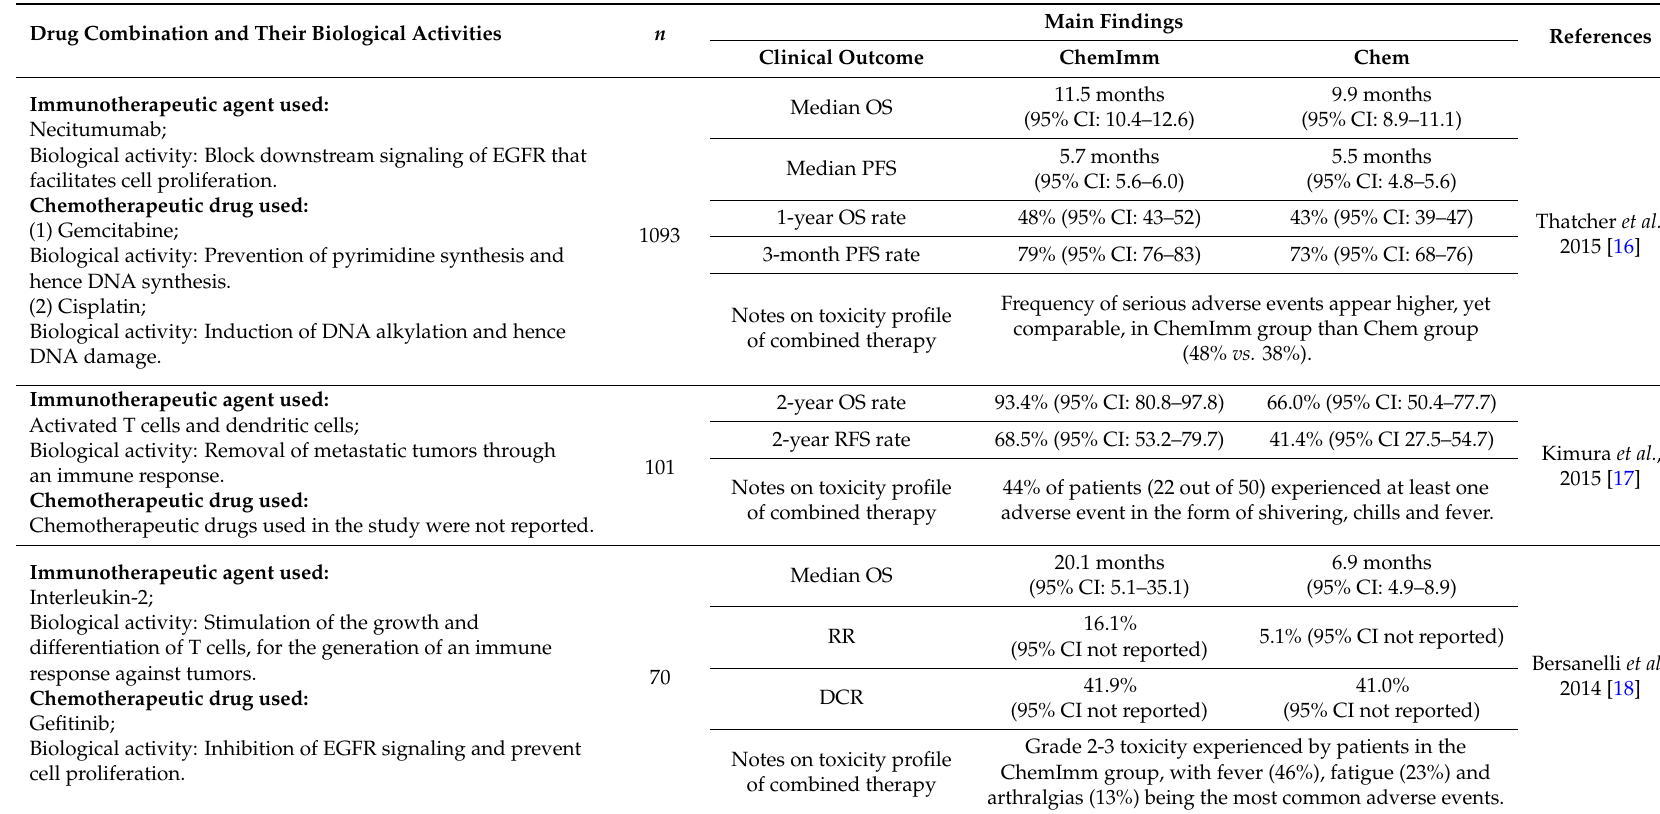
Table 1. An overview of recent clinical studies demonstrating the benefits of combination therapy over